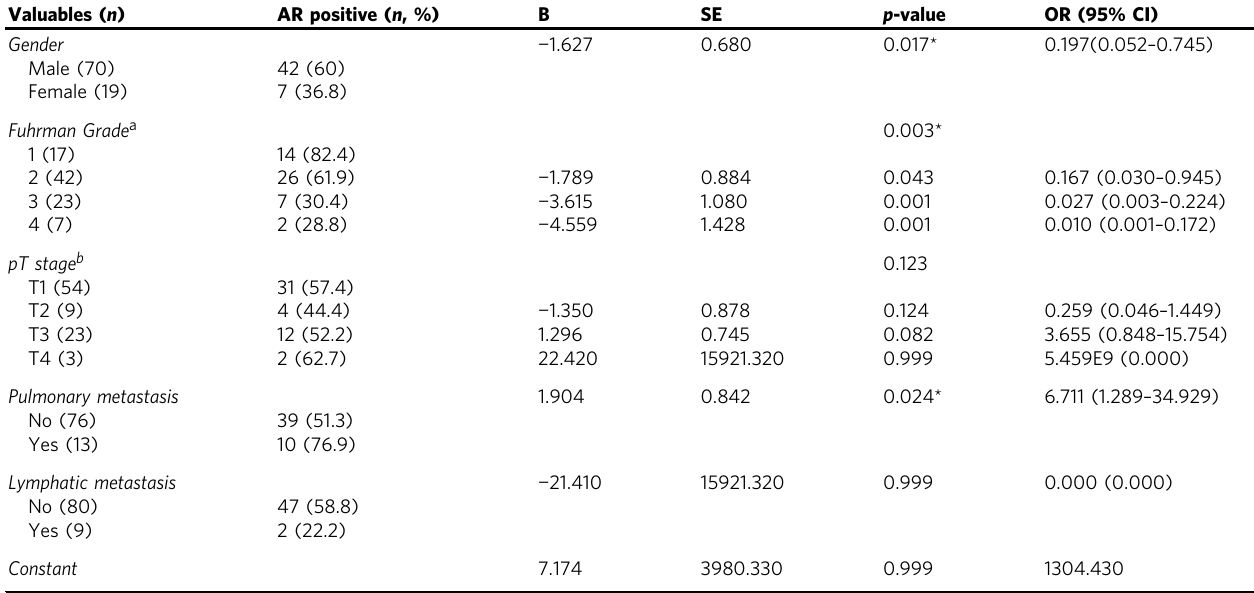
Table 1 Association of AR expression with ccRCC specimens ’ characteristics analyzed by logistic regression Valuables ( n